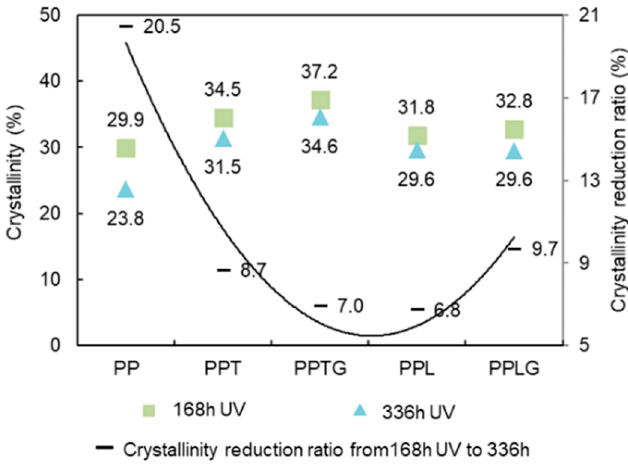
Figure 9. The crystallinity of PP and PP / polyphenol blends over exposure time.